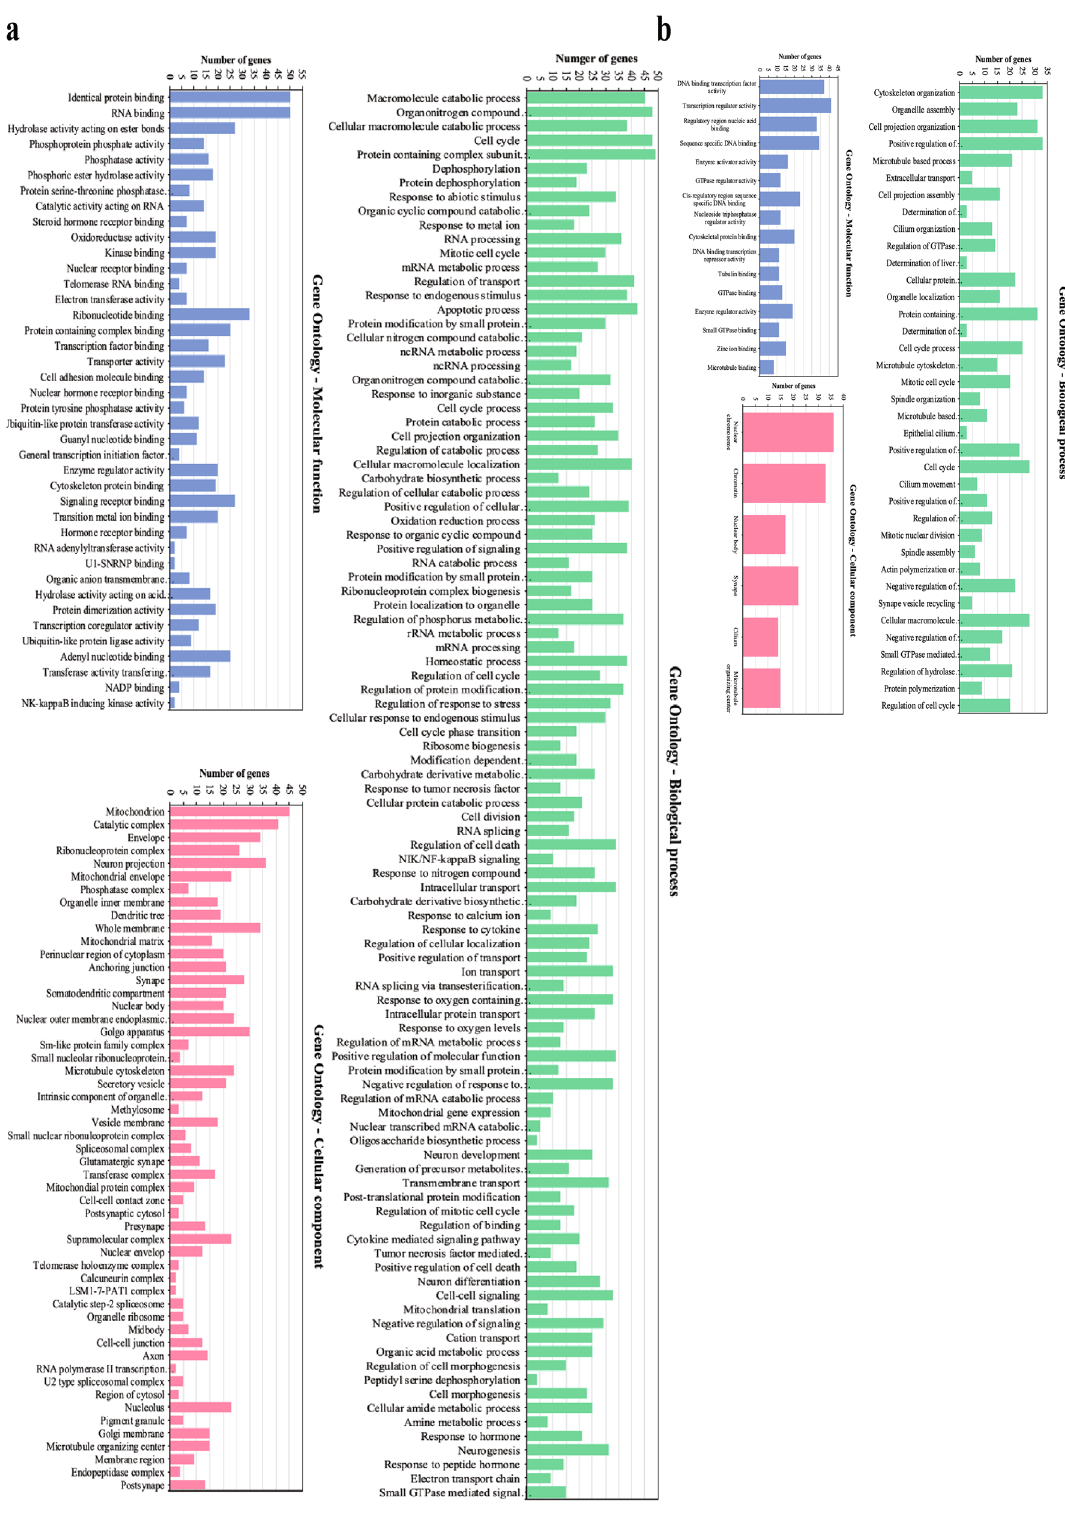
Figure 4. The bar charts of the significant GO categories enriched by the upregulated ( a ) and the downregulated ( b ) DEGs in the 2BmCherry transcriptome. The x -axis represents the name of a certain GO term. The y -axis refers to the number of the genes enriched in the